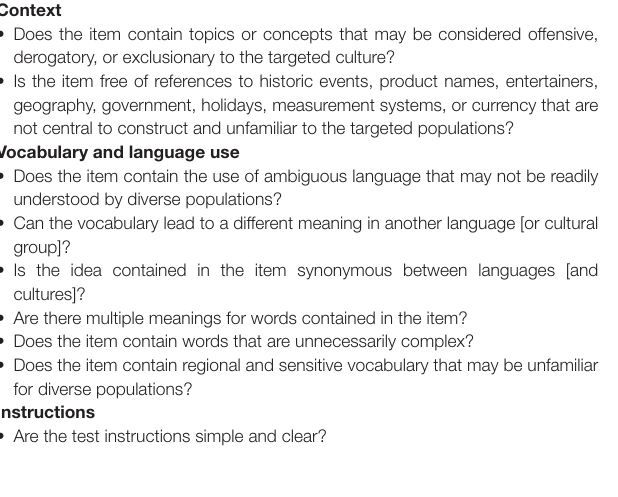
TABLE 1 | Modification checklist for construct-irrelevant language guided by the ITC guidelines (2018).